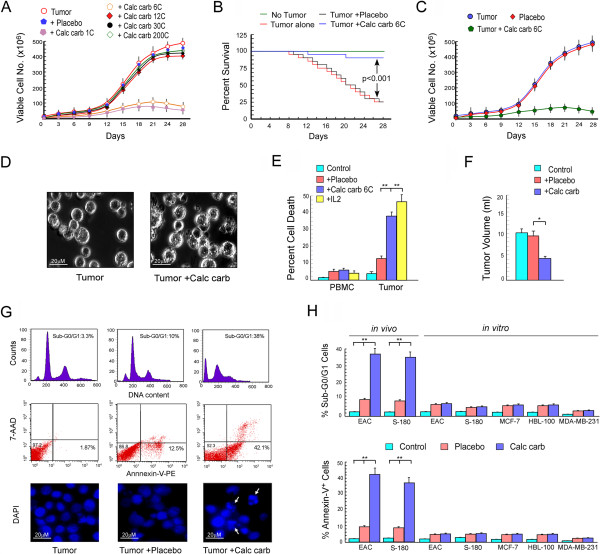
Calcarea carbonica induced tumor apoptosis in vivo but not in vitro. Swiss albino mice were intra-peritoneally injected with 1×106 EAC (Ehrlich’s ascites carcinoma). After 1 week, placebo/calcarea carbonica (1C, 6C, 12C, 30C and 200C) were administered orally for 27 days. (A) Hereafter every 3 days the viable EACs were counted from the peritoneal cavity of mice and represented graphically. (B) Kaplan-Meir plot depicting survival rates in untreated, placebo- and calcarea carbonica-treated tumor-bearing mice. Arrow heads represent the statistical significance between survival percentages of un-/calcarea carbonica-treated tumor-bearing mice (p < 0.001). (C) Graphical representation of tumor cell viability after re-treatment with calcarea carbonica for 27 days to confirm that calcarea carbonica does not induce resistance. (D) Phase contrast images showing morphological changes of EAC cells after drug treatment. Bar length in images indicate 20 μm (E) At day 21 after placebo-/calcarea carbonica-/IL2-treatment percent PBMC and tumor cell death was determined by Trypan blue dye-exclusion test. (F) Graphical representation of tumor volume from placebo-/calcarea carbonica-treated tumor-bearing mice at day 21. (G) The nature of calcarea carbonica-induced tumor cell was assayed flow cytometrically using cell cycle phase distribution assay (upper panel) and Annexin-V-PE/7-AAD double labelling assay (middle panel). DAPI staining revealed nuclear morphology of apoptotic cells as indicated by arrowheads (lower panel). Bar length in images indicate 20 μm. (H) Graphical representation of percent apoptosis from control, untreated, placebo- and calcarea carbonica-induced murine and human cancer cell death was measured flow cytometrically under both in vitro and in vivo conditions. Values are mean ± SEM of five independent experiments. *p < 0.05 and **p < 0.001 when compared with respective control/treated groups.